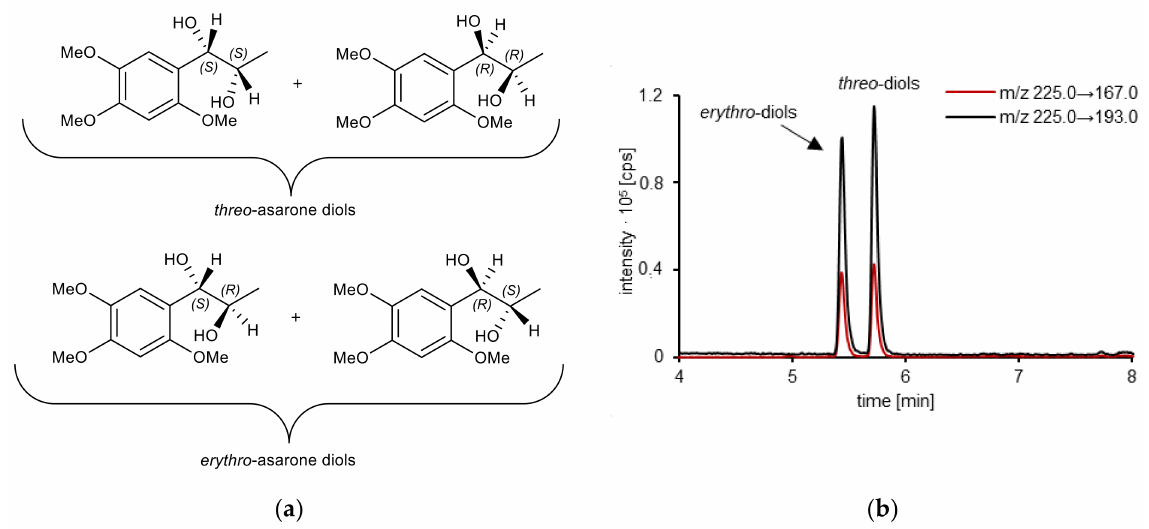
Figure 3. ( a ) Structural illustration of erythro - and threo -asarone diols and their stereochemistry. ( b ) HPLC-MS/MS chromatogram of a 1:10 diluted urine sample spiked with 5 ng/mL of erythro- and threo-asarone diols. Presented are the quantifier ( m / z 225 → 193) and qualifier ( m / z 225 → 167) SRM